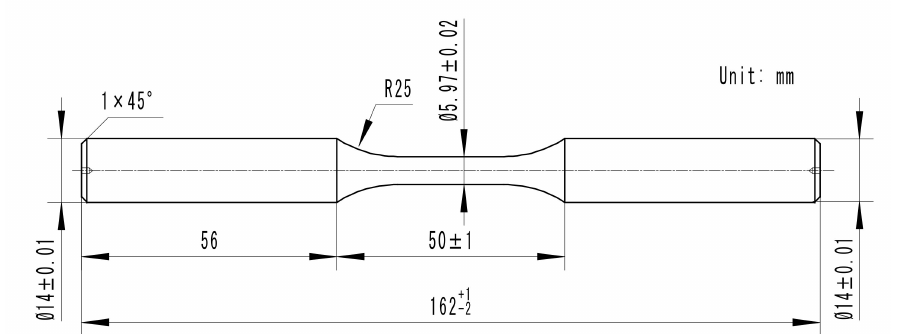
Figure 1. The shape and dimensions of the specimens for the tensile tests.